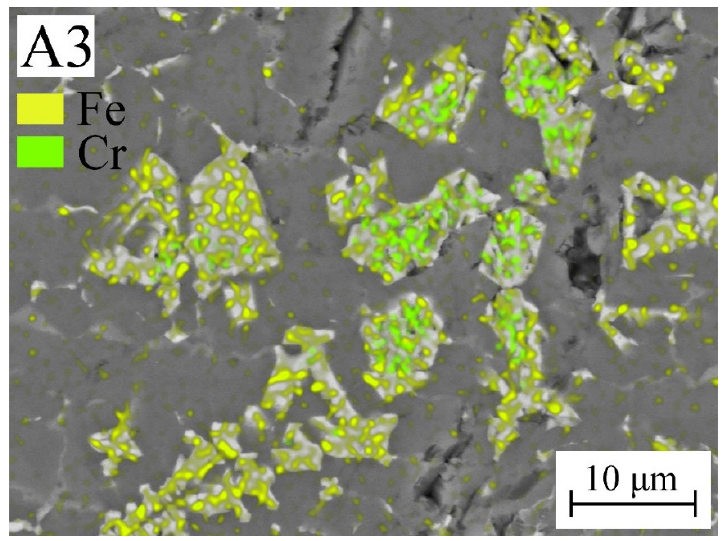
Figure 3. Distribution of Fe and Cr elements in the spine phase in Sample A3 according to EDS mapping results.